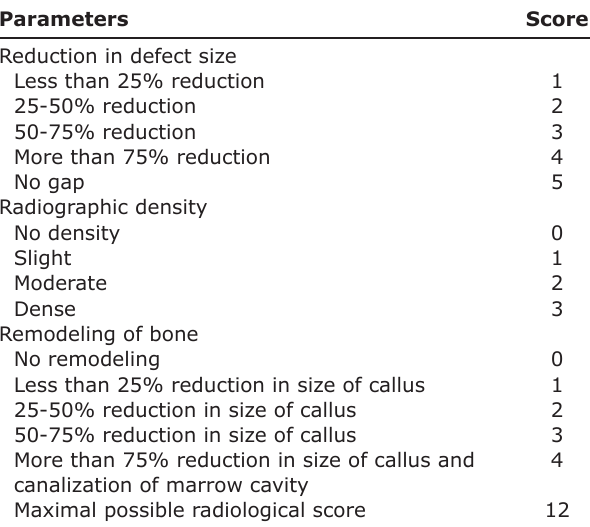
Table-1: Modified Lane and Sandhu [11] radiological scoring system. Parameters